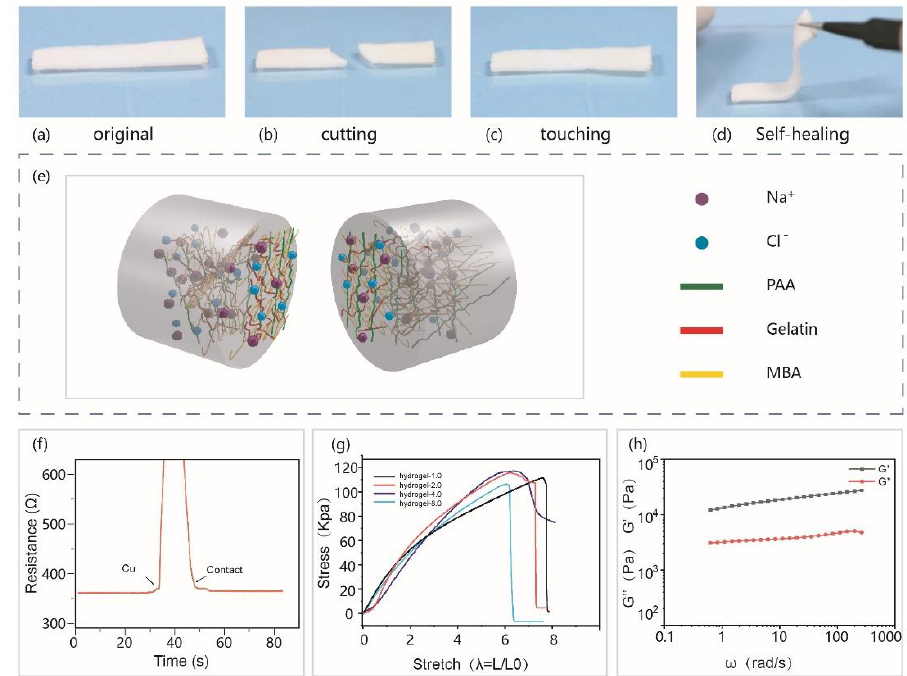
Figure 2. Self-healable property of PAA-Gel-NaCl hydrogel. ( a – d ) photographs of the PAA-Gel-NaCl hydrogel before and after self-healed. ( e ) The schematic diagram of the structure of the PAA-Gel-NaCl ionic hydrogels. ( f ) The capability of electrical recovery after sliced. ( g ) uniaxial tensile test of PAA-Gel-NaCl hydrogels with different gelatin content. ( h ) The storage and loss moduli as a function of frequency (1% strain).